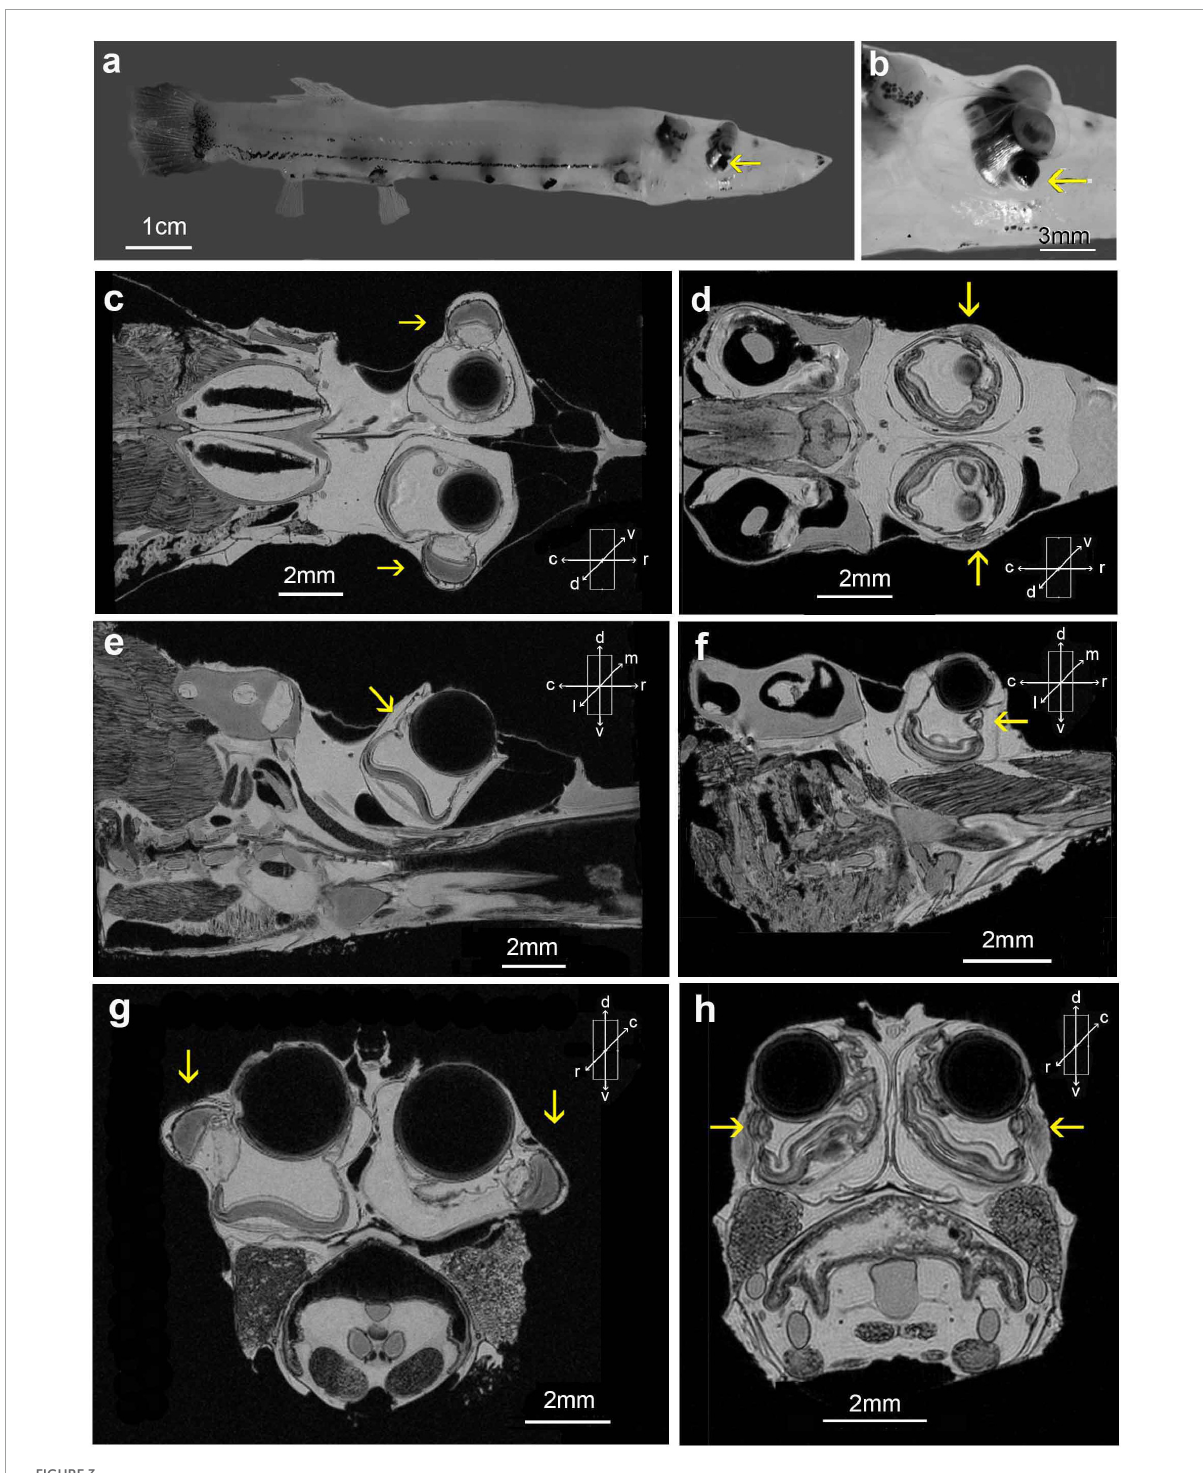
FIGURE3 Dolichopteryx longipes (a,b) side views of an animal with SL 93 mm; (c,e,g) MRI scans from this specimen; (d,f,h) equivalent scans from a smaller animal (SL 52 mm). MRI scans were taken at the central level, where lens diameter is maximal, of the left tube eye in the sagittal (e,f) , and transverse (g,h) planes. MRI scans in the horizontal plane (c,d) were taken at the level best illustrating the diverticula. Yellow arrows indicate